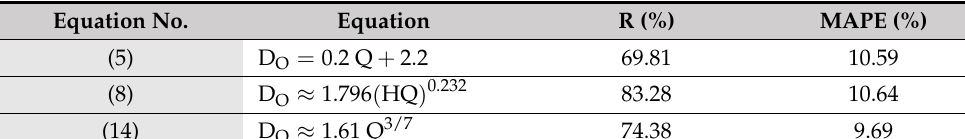
Table 3. Evaluation of equations based on the evaluation criteria. Equation No.